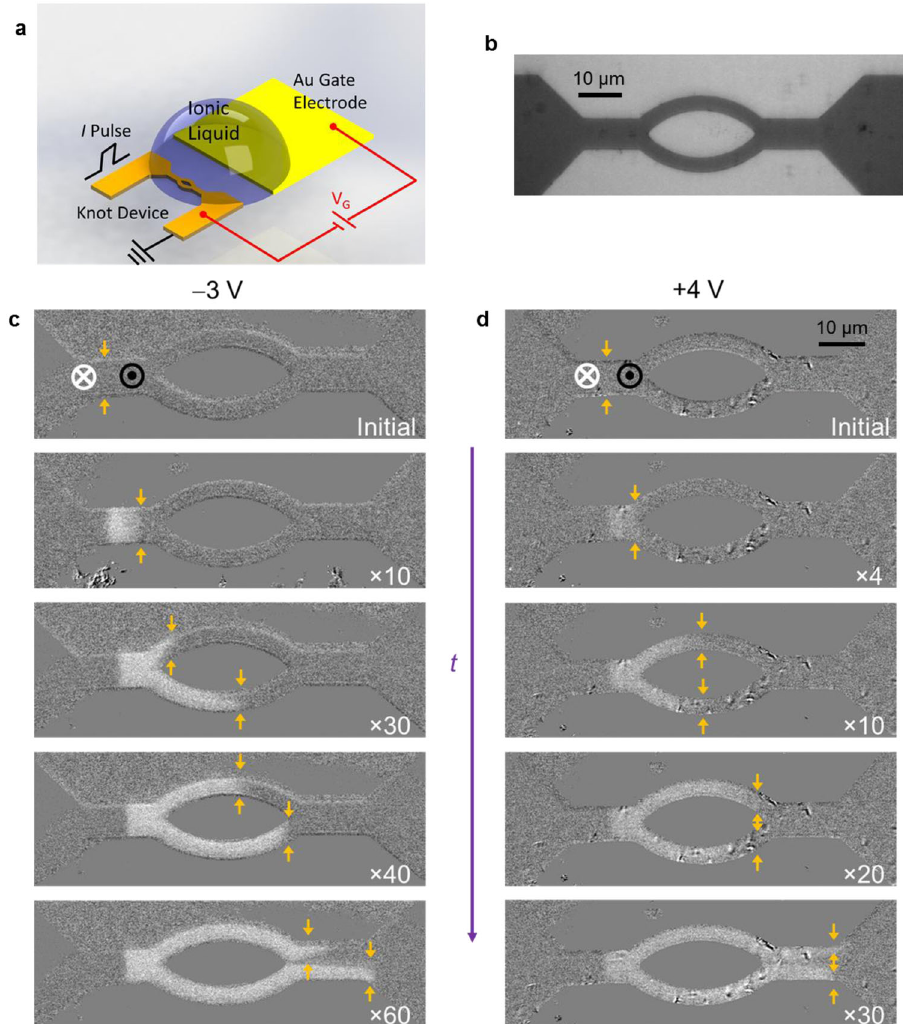
Fig. 4 Knot devices controlled via ILG. a Sketch of experimental setup for a knot device controlled by ionic liquid gating. b Optical micrograph of a typical knot device. Current-induced domain wall motion of a SAF knot device for V G = − 3 V ( c ) and + 4 V ( d ). Current pulses with a magnitude and length of 1.2 × 10 8 A cm − 2 and 50 ns, respectively, were used. The injected pulse numbers are labeled at the low right corner and the current DW position is marked with the yellow arrows in each fi